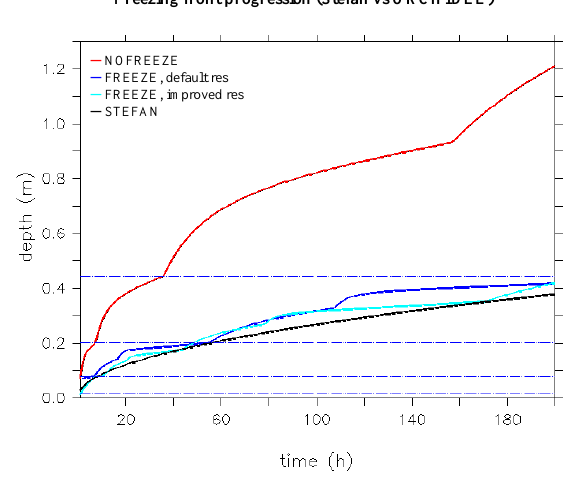
Fig. 2. Freezing front progression as calculated by the Stefan solu- tion (STEFAN) and simulated by three ORCHIDEE simulations: without soil-freezing (NOFREEZE); with the soil-freezing ther- mal algorithm at the default resolution (FREEZE, default res), and with the soil-freezing thermal algorithm at an improved resolution (FREEZE, improved res). The horizontal dashed lines mark the po- sitions of the vertical nodes in the default thermal resolution.